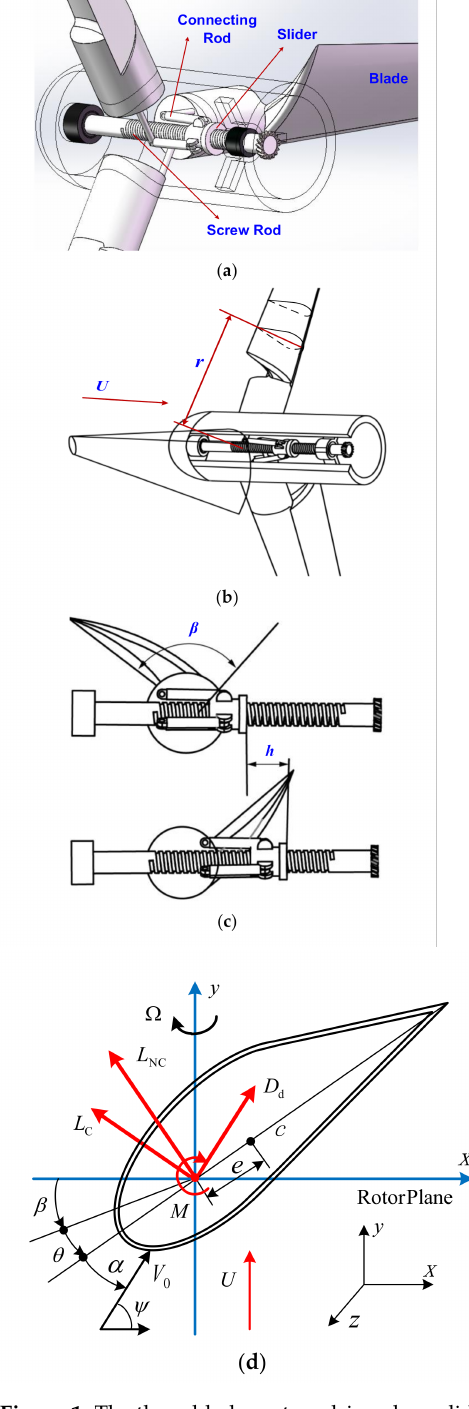
Figure 1. The three-blade system driven by a slider-linkage mechanism by using unified pitch motion. ( a ) The auxiliary stereoscopic visual effect; ( b ) The half profile structure; ( c ) The slider displacement h of and the corresponding pitch angle β ( d ) The sectional coordinate